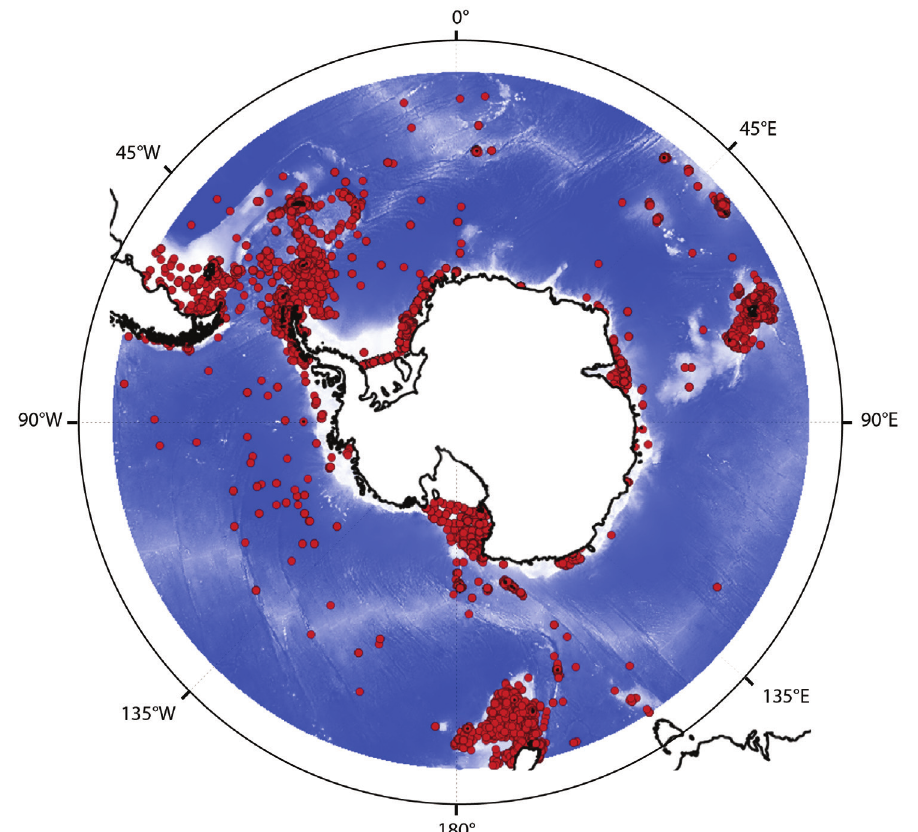
Figure 1. Map of the 13,840 asteroid species occurrences available in the present database, within the boundaries of the Southern Ocean (45°S). Projection: South Pole